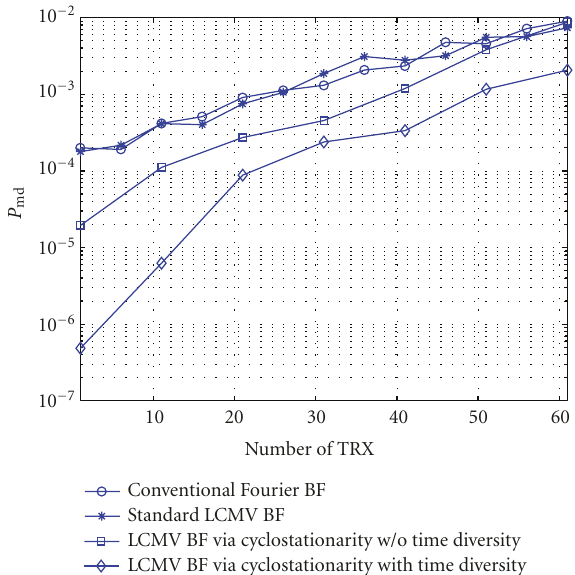
Figure 11: LCMV BF result with using